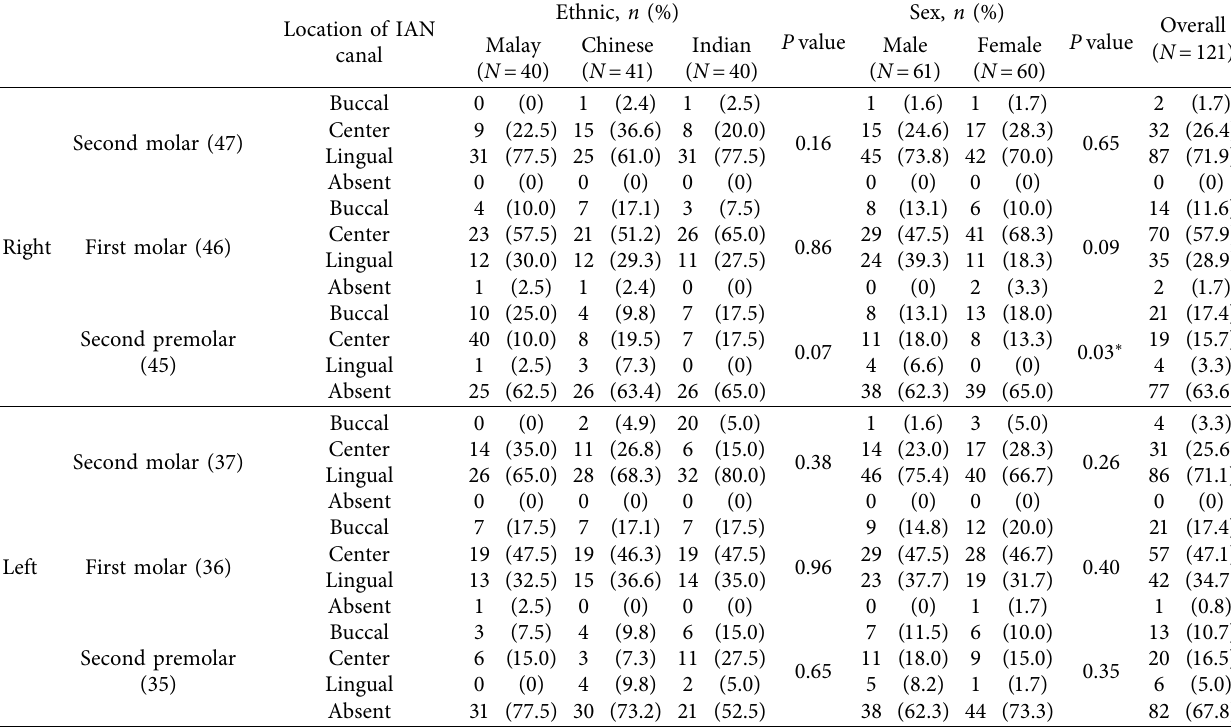
Table 1: The buccolingual positioning of IAN canal in each respective tooth according to the ethnicity and sex group among Malaysian population.